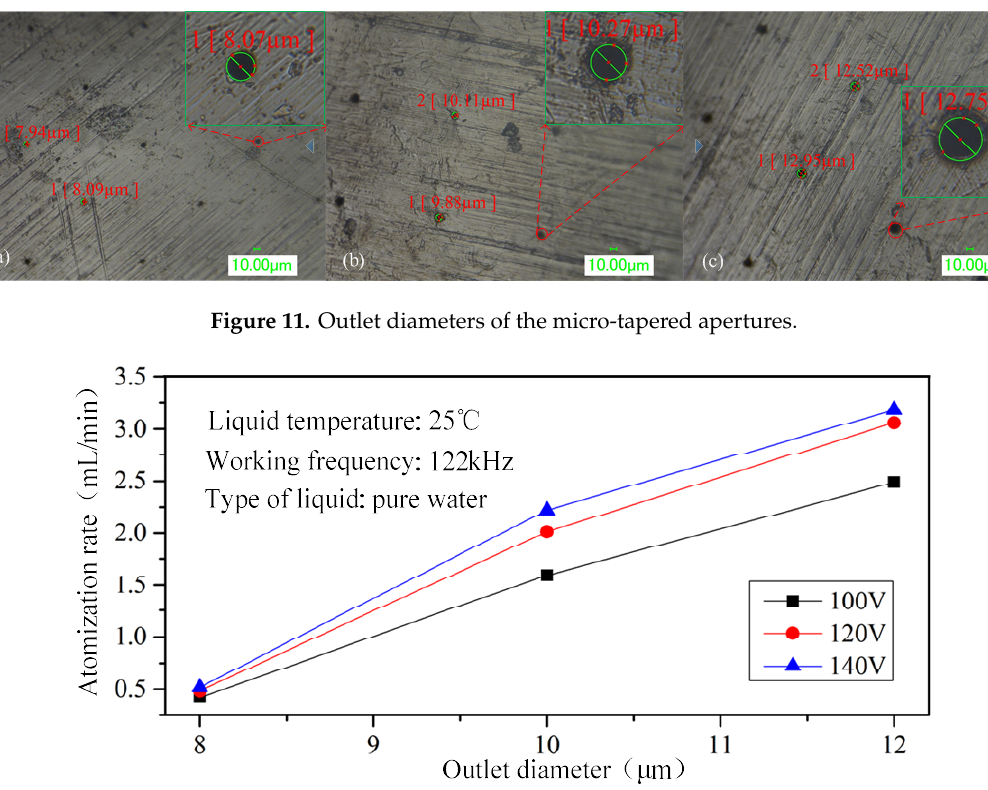
Figure 12. Relationship between the atomization rate and micro-tapered aperture size.